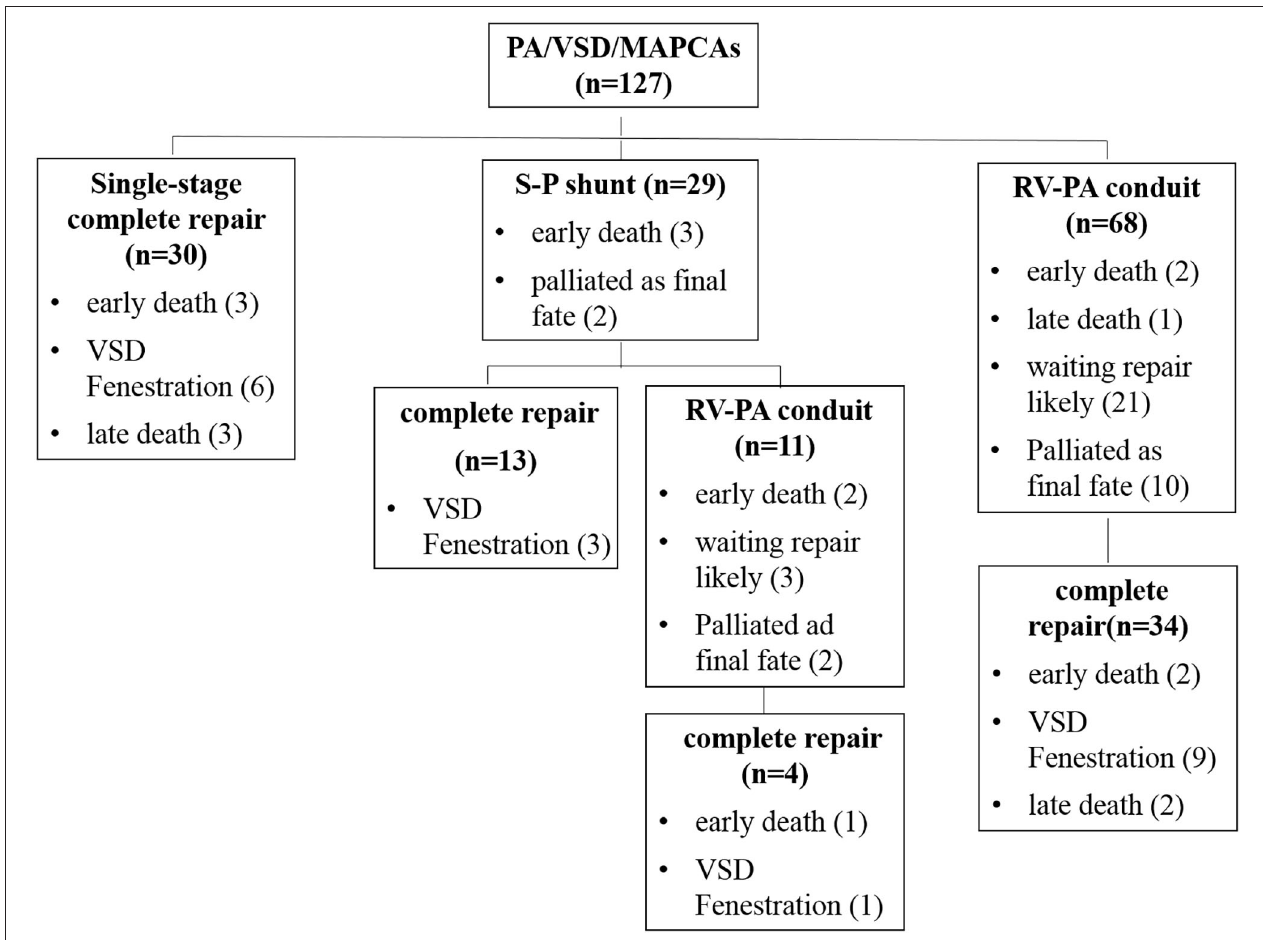
FIGURE 1 | The outcomes of 127 PA/VSD/MAPCAs patients with combined strategy.